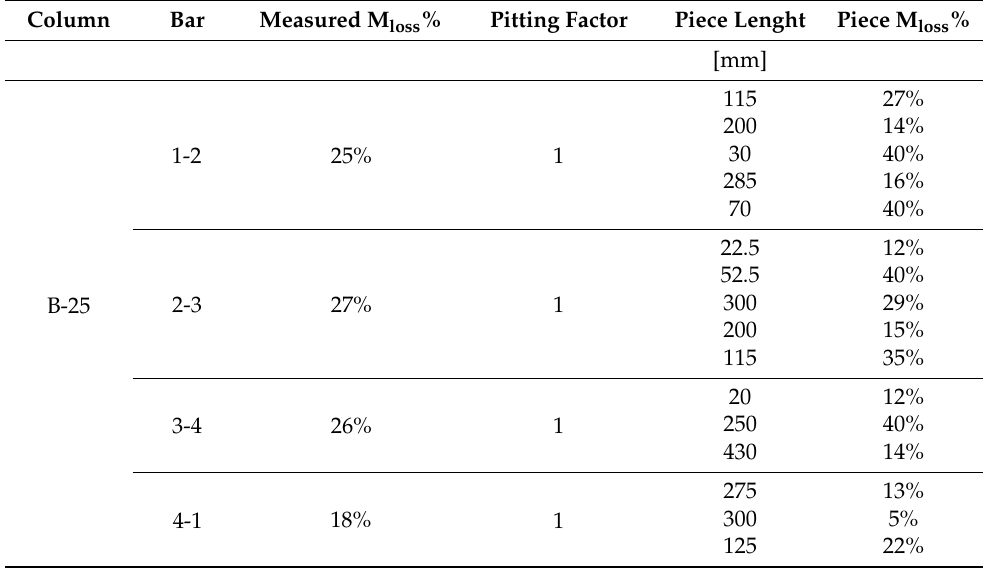
Table 5. Pitting factor and lost mass assumed for strategy 4, column B25.